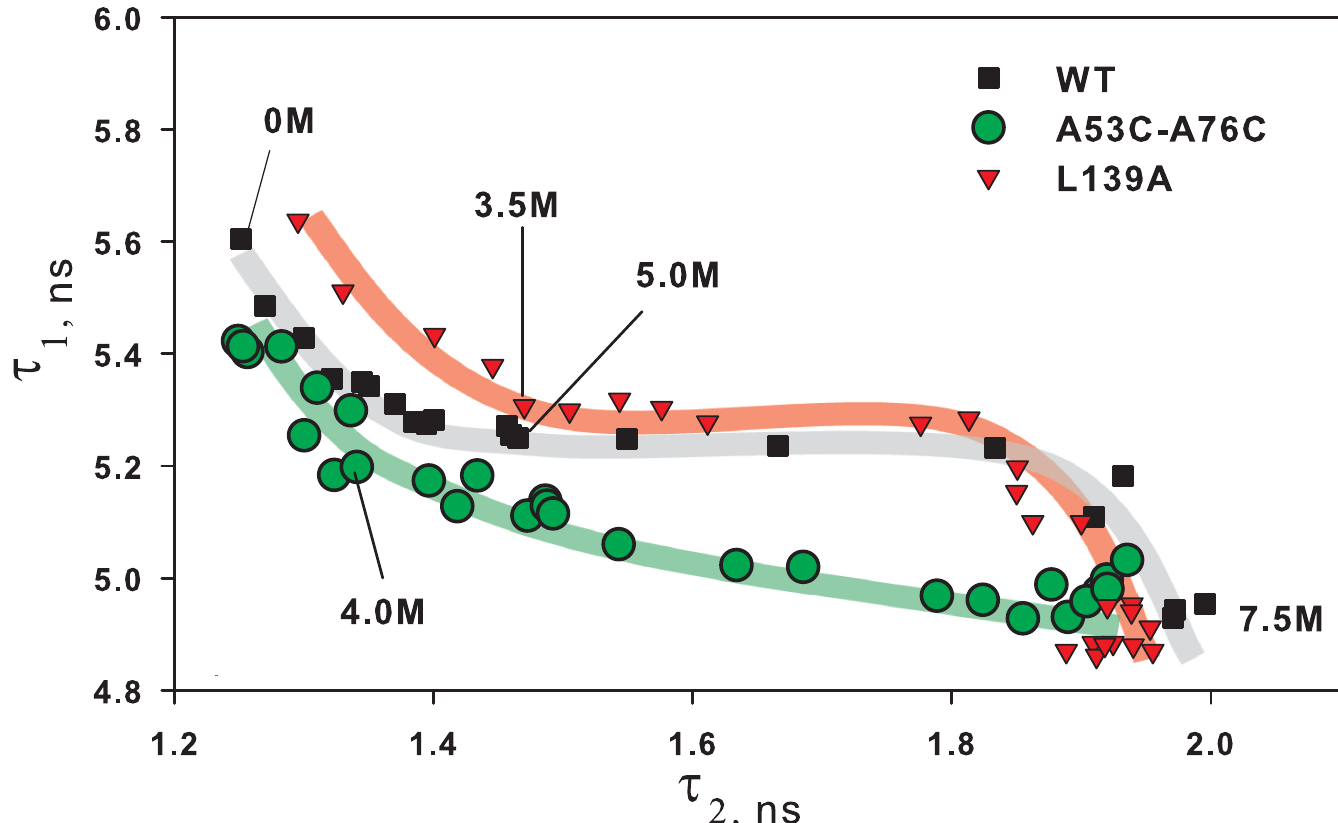
Fig 4. Phase diagram of two fluorescence lifetime components. Interdependence of two fluorescence lifetime components τ 1 and τ 2 of wild-type BCA II ( ■ WT) and its two mutant forms ( ▼ L139A and ● A53C-A76C). Each point was obtained by fitting fluorescence decay curves of protein solution at definite urea concentration. Thick color lines show the “unfolding pathway” for each protein with increase in urea concentration from 0 to 7.5 M. The relative deviations for τ 1 and τ 2 were � 3% and � 7% correspondingly.